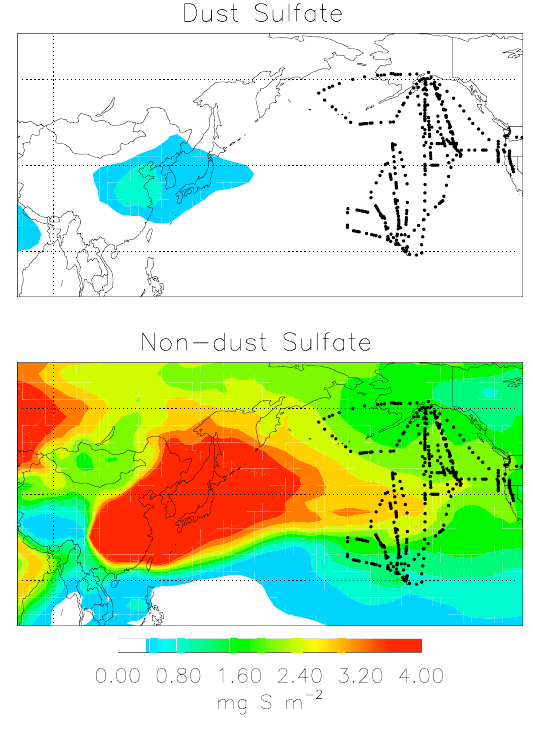
Fig. 7. As for Fig. 6, but for simulated dust and non-dust sulfate.